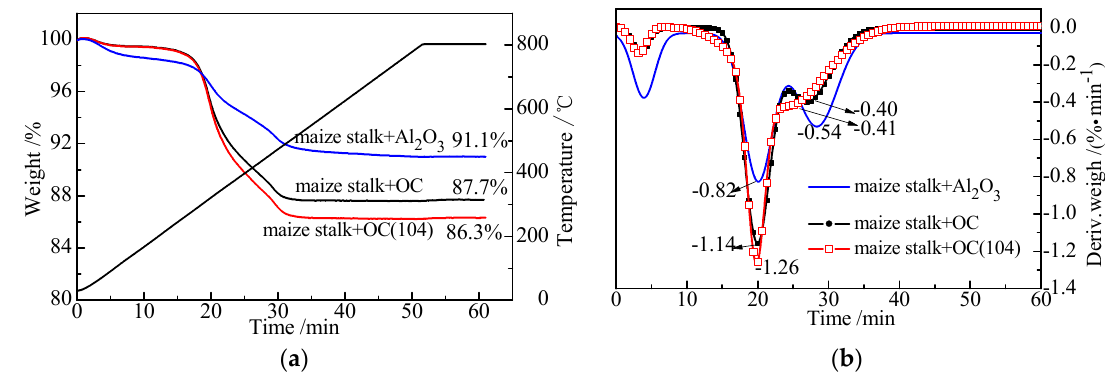
Figure 2. Thermogravimetric (TG) and differential thermogravimetric (DTG) curves for different samples. ( a ) TG curves; ( b ) DTG curves.